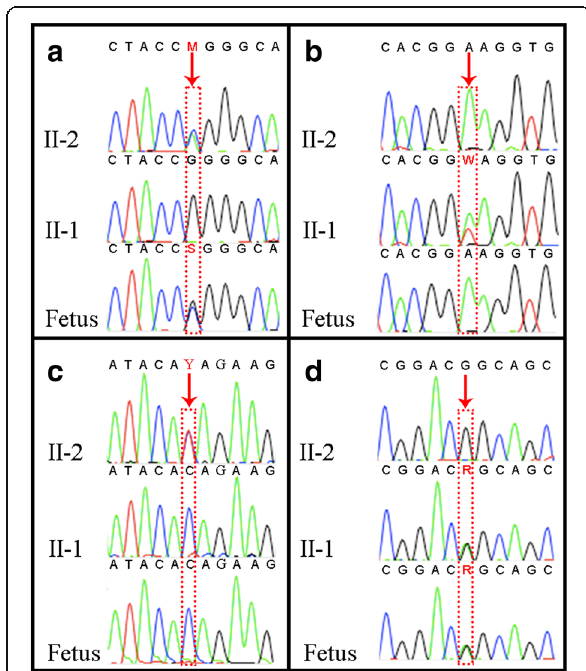
Fig. 2 Sequencing of the couple ’ s DNA and amniocyte DNA. a The foetus harboured the c.1238G > C mutation in the F7 gene inherited from his father (II-2), who is a carrier of the compound heterozygous mutations c.1238G > A and c.1238G > C in the F7 gene. b The mother (II-1) harboured the heterozygous c.1126A > T F7 mutation, but this mutation was absent in the foetus. c The father (II-2) harboured the heterozygous c.3659C > T mutation in the CFTR gene, but this mutation was absent in the foetus. d The foetus harboured the c.3209G > A mutation in the CFTR gene inherited from his mother (II-1). The red arrows indicate c.1238 and c.1126 in F7,